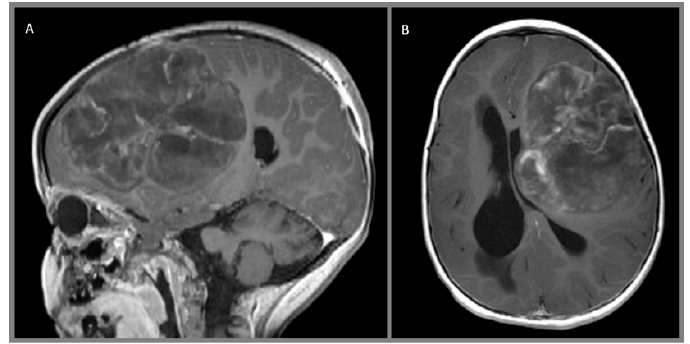
Figure 3. Giant ganglioglioma with extensive chondroid metaplasia, WHO I, arising from the left frontal lobe demonstrates multinodular architecture and sparse, heterogeneous contrast enhancement on these ( A ) sagittal and ( B ) axial T1 MPRAGE contrast-enhanced images.